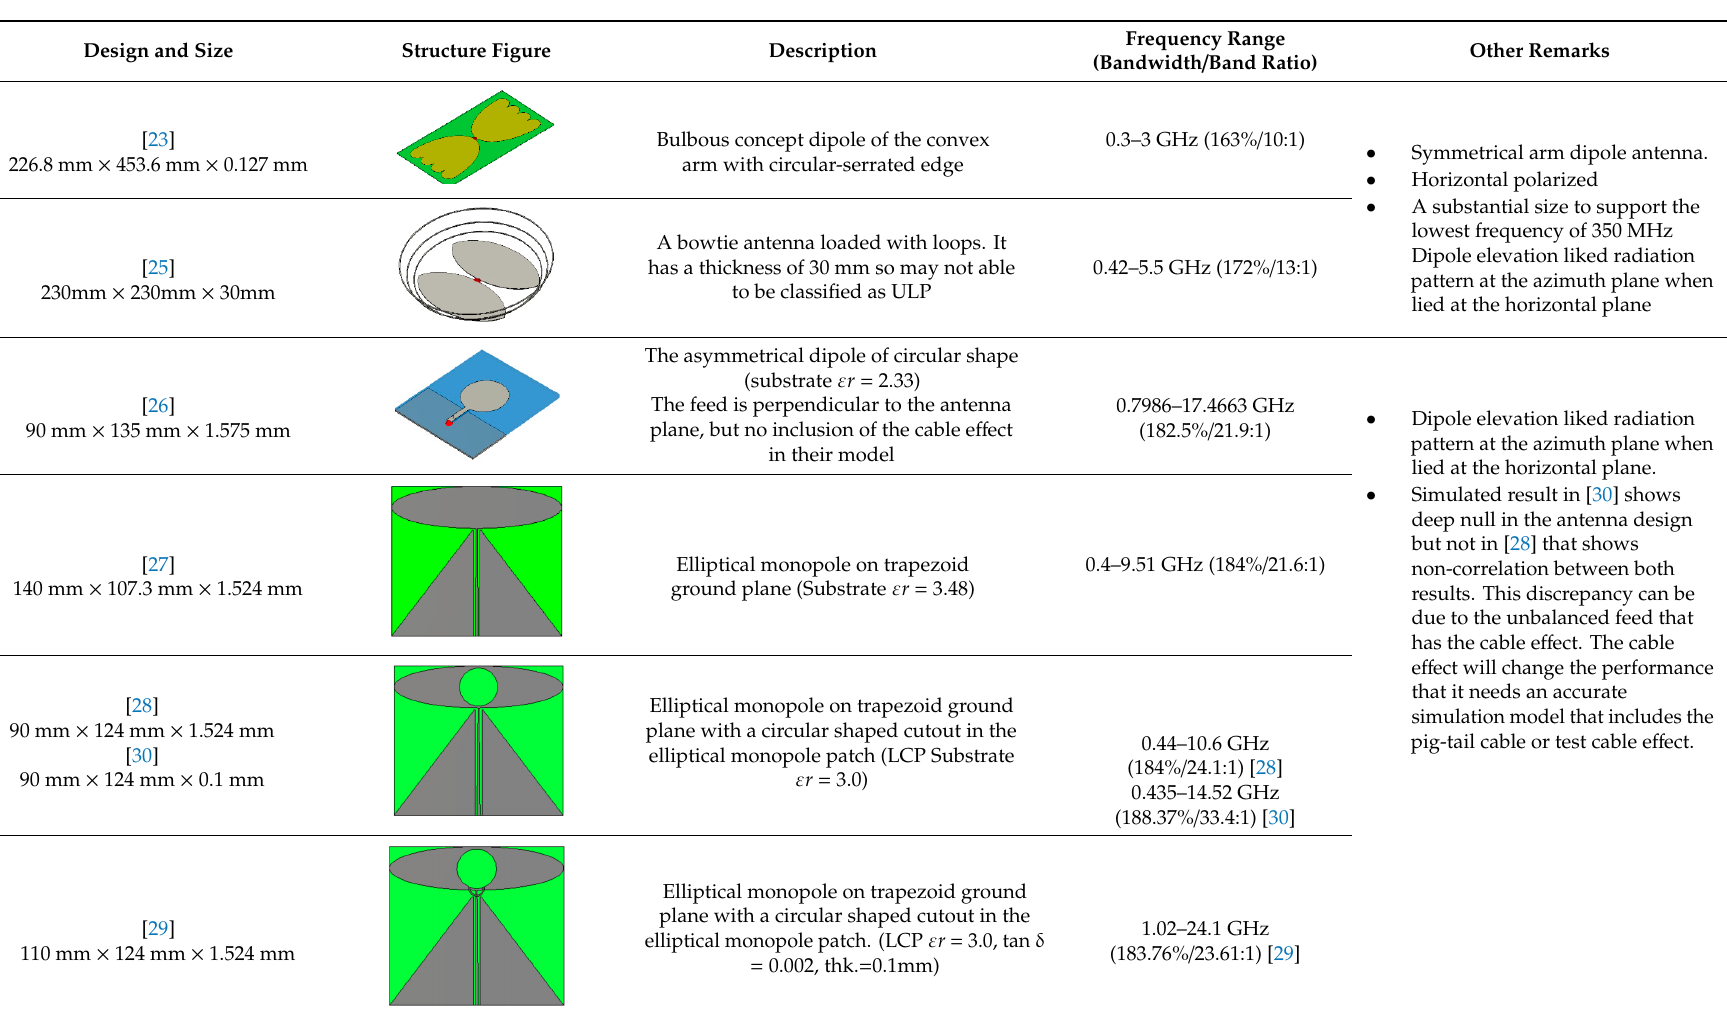
Elliptical monopole on trapezoid ground plane with a circular shaped cutout in the elliptical monopole patch. (LCP ε r = 3.0, tan δ = 0.002, thk. =